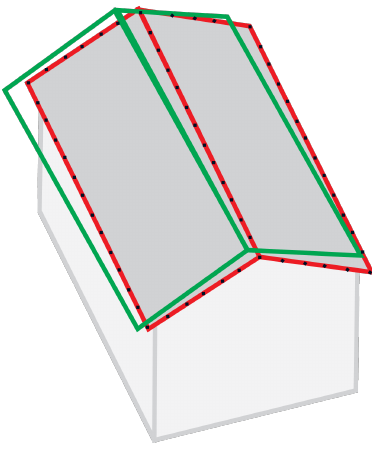
Figure 4: Fitting algorithm used in this research. Wire frame edges (in green), edge lines (in red), sampling points (with black dots) are also